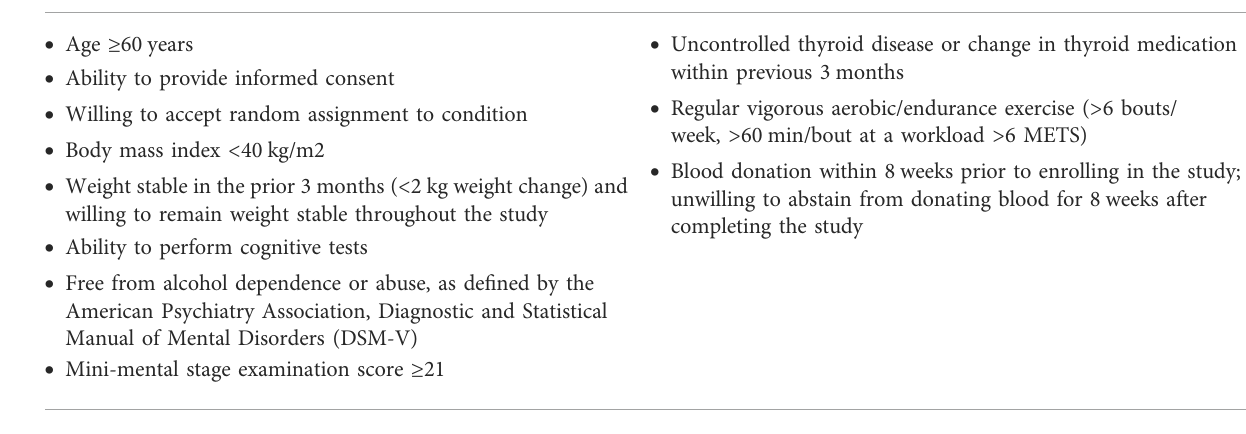
TABLE 1 Inclusion and Exclusion Criteria. METs = metabolic